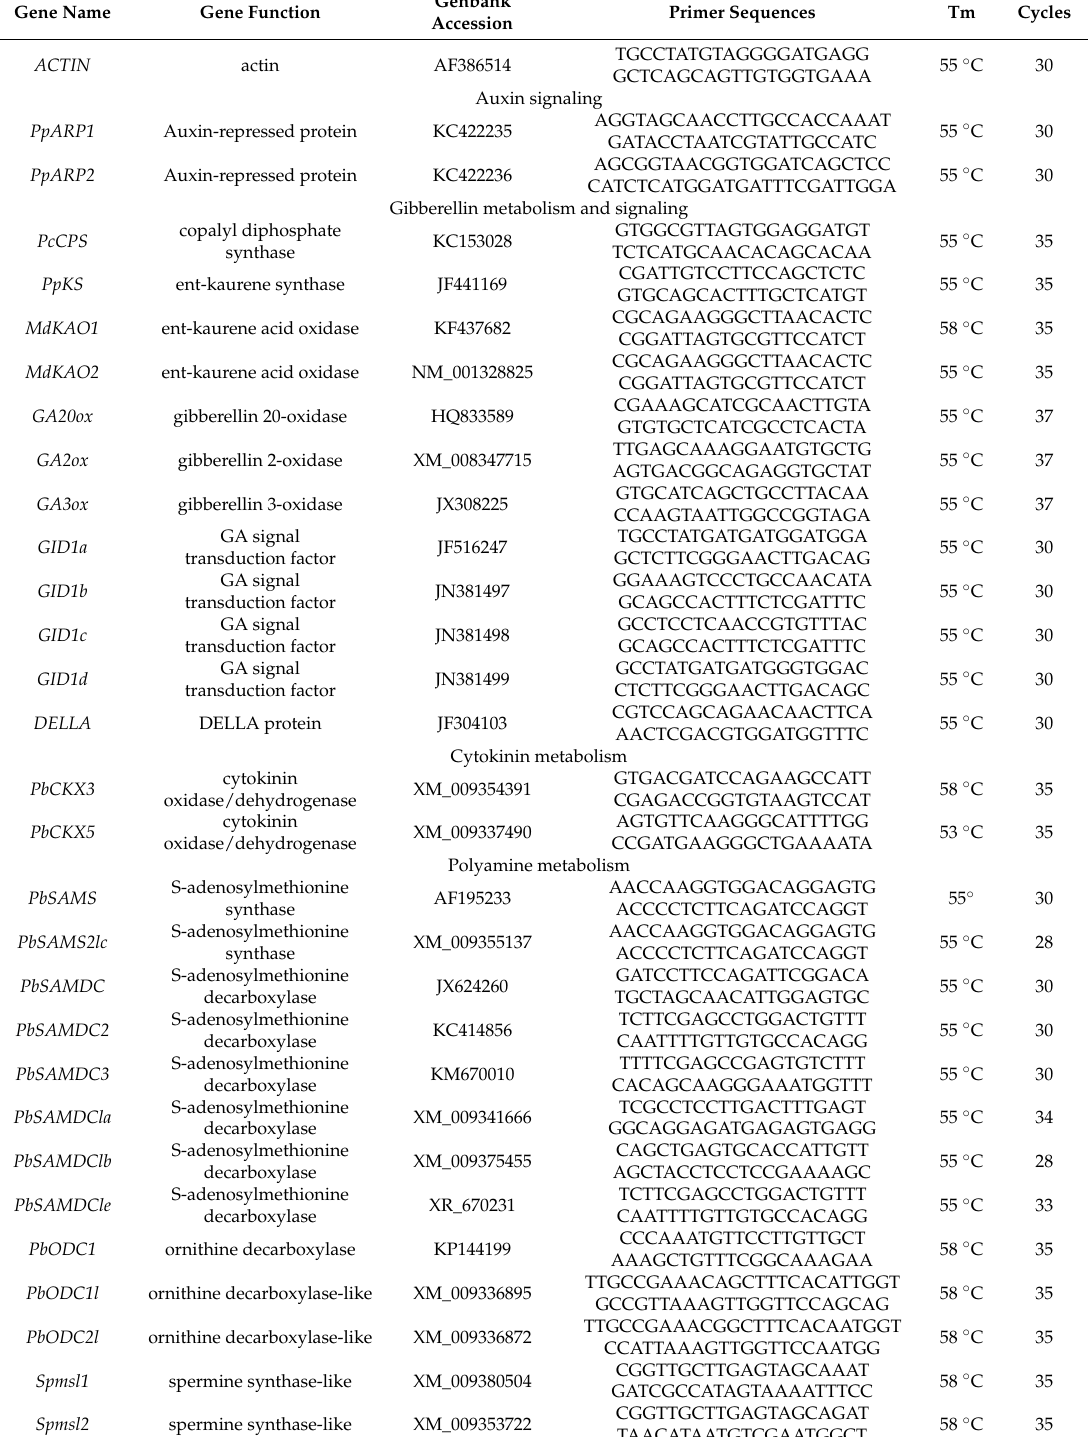
Table 1. List of primers and amplification conditions used for semi-quantitative RT-PCR expression